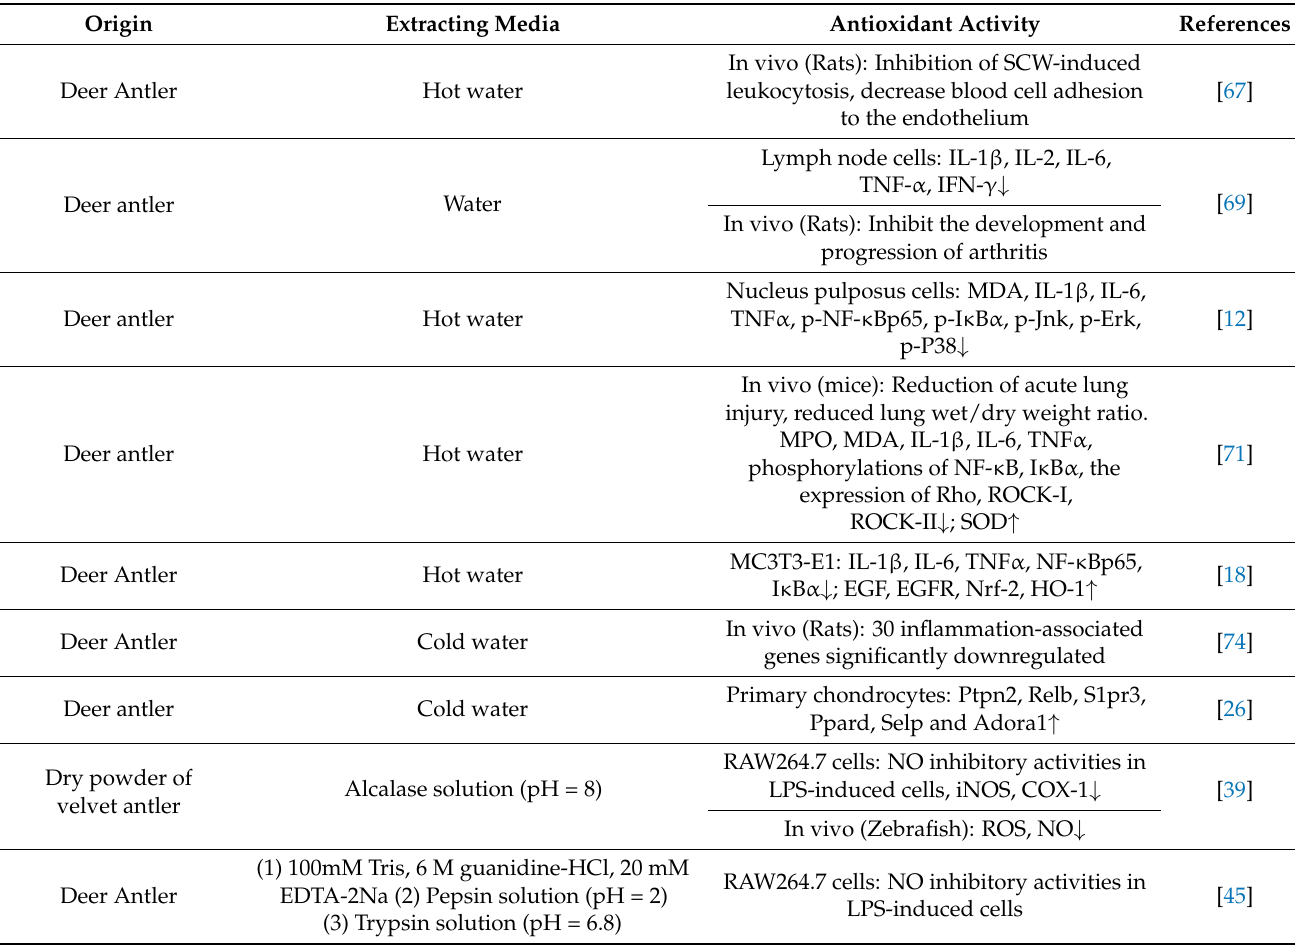
Table 4. Anti-Inflammation activity of